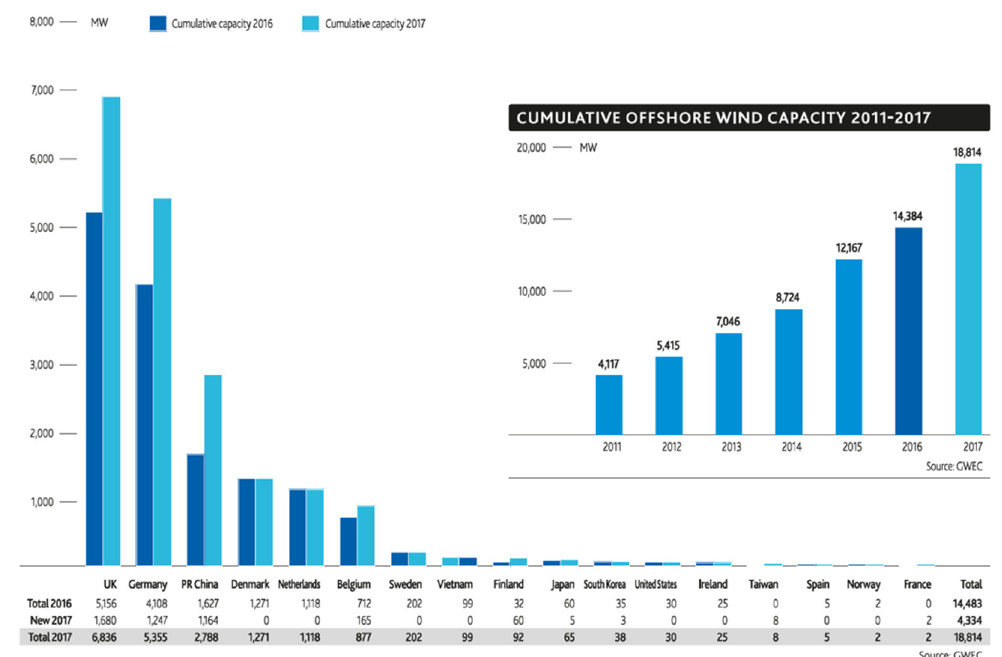
Figure 1. Global cumulative offshore wind capacity in 2017 [2].